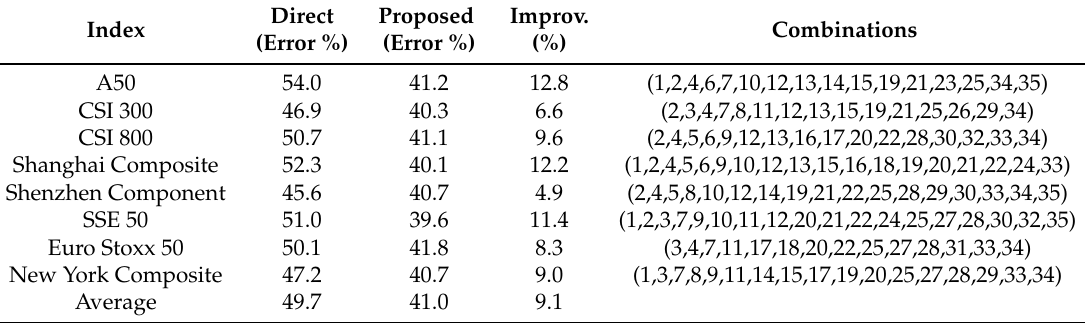
Table 3. Classification errors (up and down index movements) of the proposed approach using neural networks compared to the direct application of neural networks using all the 35 technical